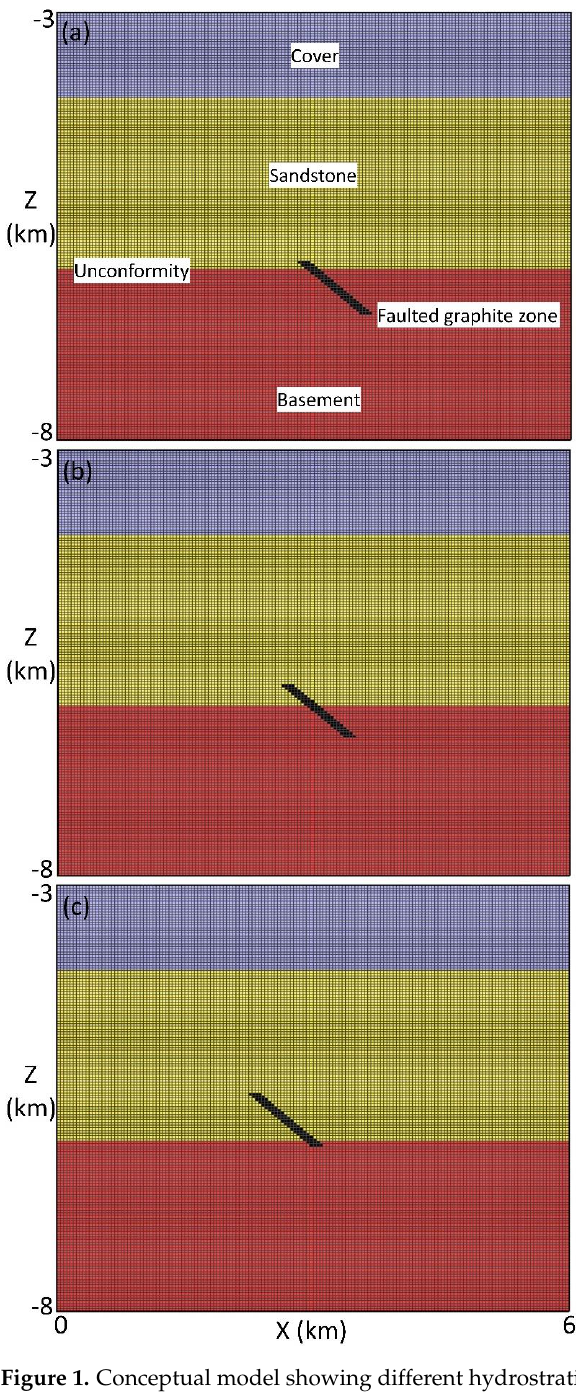
Figure 1. Conceptual model showing different hydrostratigraphic units and scenarios: ( a ) Scenario 1 with the fault zone mainly in the basement unit, ( b ) Scenario 2 with the fault zone straddling the unconformity, and ( c ) Scenario 3 with the fault zone mainly in the sandstone layer. The top and bottom are set at a constant temperature of 90 °C and 240 °C, respectively. The bottom and side boundaries are assumed impermeable, but the top is set at a fixed fluid pressure of 30 MPa. The top and bottom have fixed mineral volume fractions and aqueous component concentrations, equal to those of their respective units. For the side boundaries, the normal gradients of the volume fractions and concentrations are set to